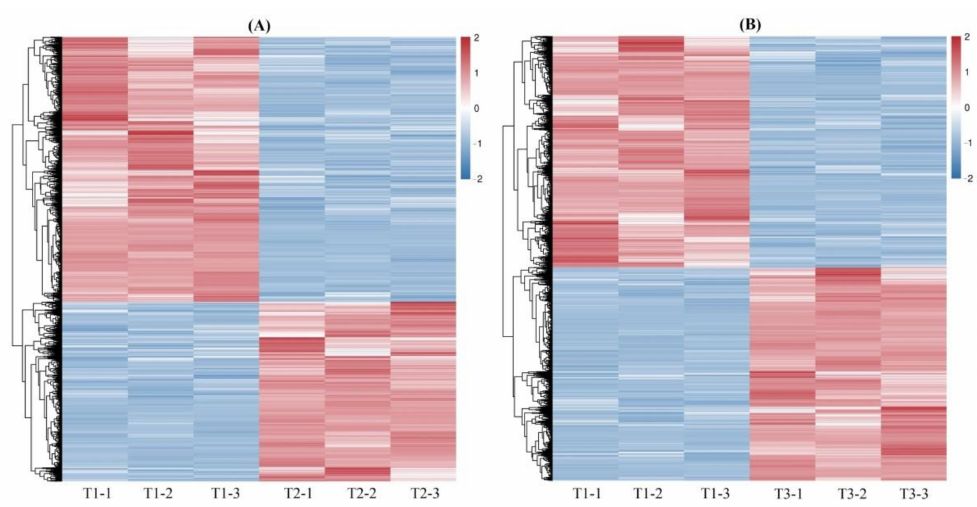
Figure 3. Cluster heat map of the DEGs at T2 vs. T1 ( A ) and T3 vs. T1 ( B